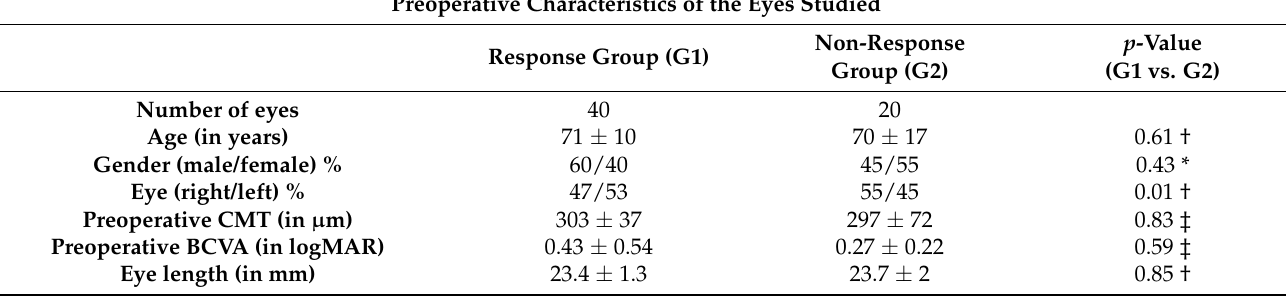
Table 1. Preoperative characteristics of the eyes